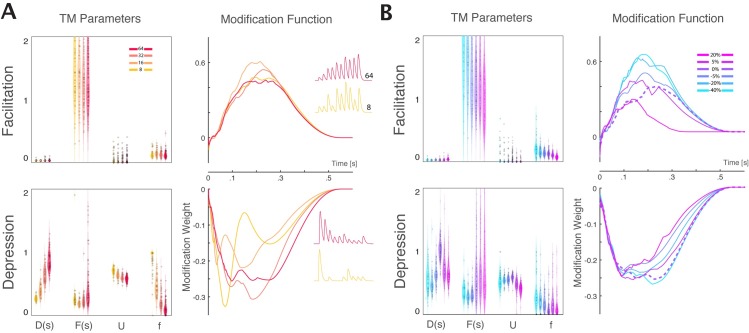
A) Stochastic vesicle release leads to a bias of STP estimates. Left panels; TM parameters for simulations with four different numbers of release sites: 8, 16, 32, and 64 (color coded). Right panels; median modification functions for 4 different release site numbers. Colors match with the left panel. B) Inaccurate spike sorting does not substantially alter STP estimates. Left panels; TM parameters estimated using simulated spiking of LIF neurons with random deletion or addition of spikes. From left to right: random deletion of -40%, -20%, -5% spikes; without deletion or insertion (0%), and with insertion of 5%, and 20% of spikes. Right panels: median modification functions for the same sets with deleted and inserted spikes (colors match with the left panel). Dashed line denotes the estimated modification function under perfect spike sorting (without insertion or deletion).